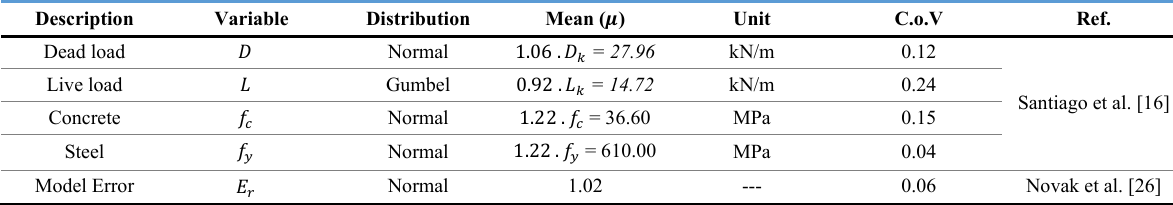
Table 4. Random variable statistics.